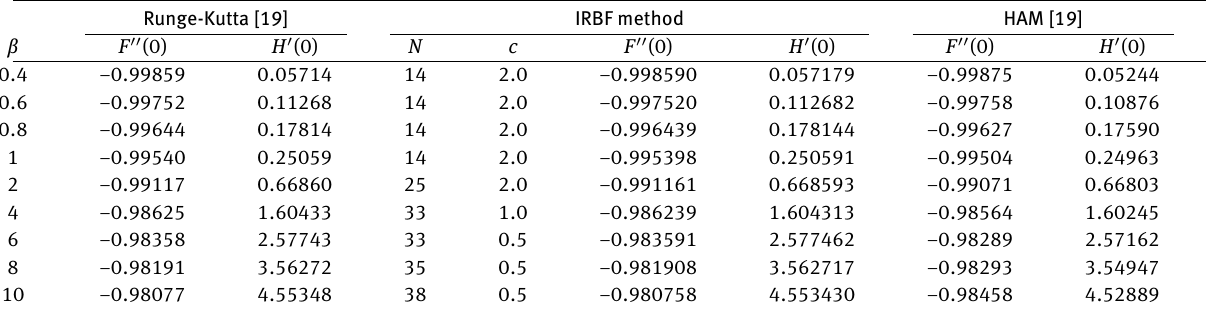
Table 5: Comparison between indirect RBFs and other solutions of F (cid:48)(cid:48) (0) and H (cid:48) (0) for some β at ε = 0.1 and ϕ = 0 .